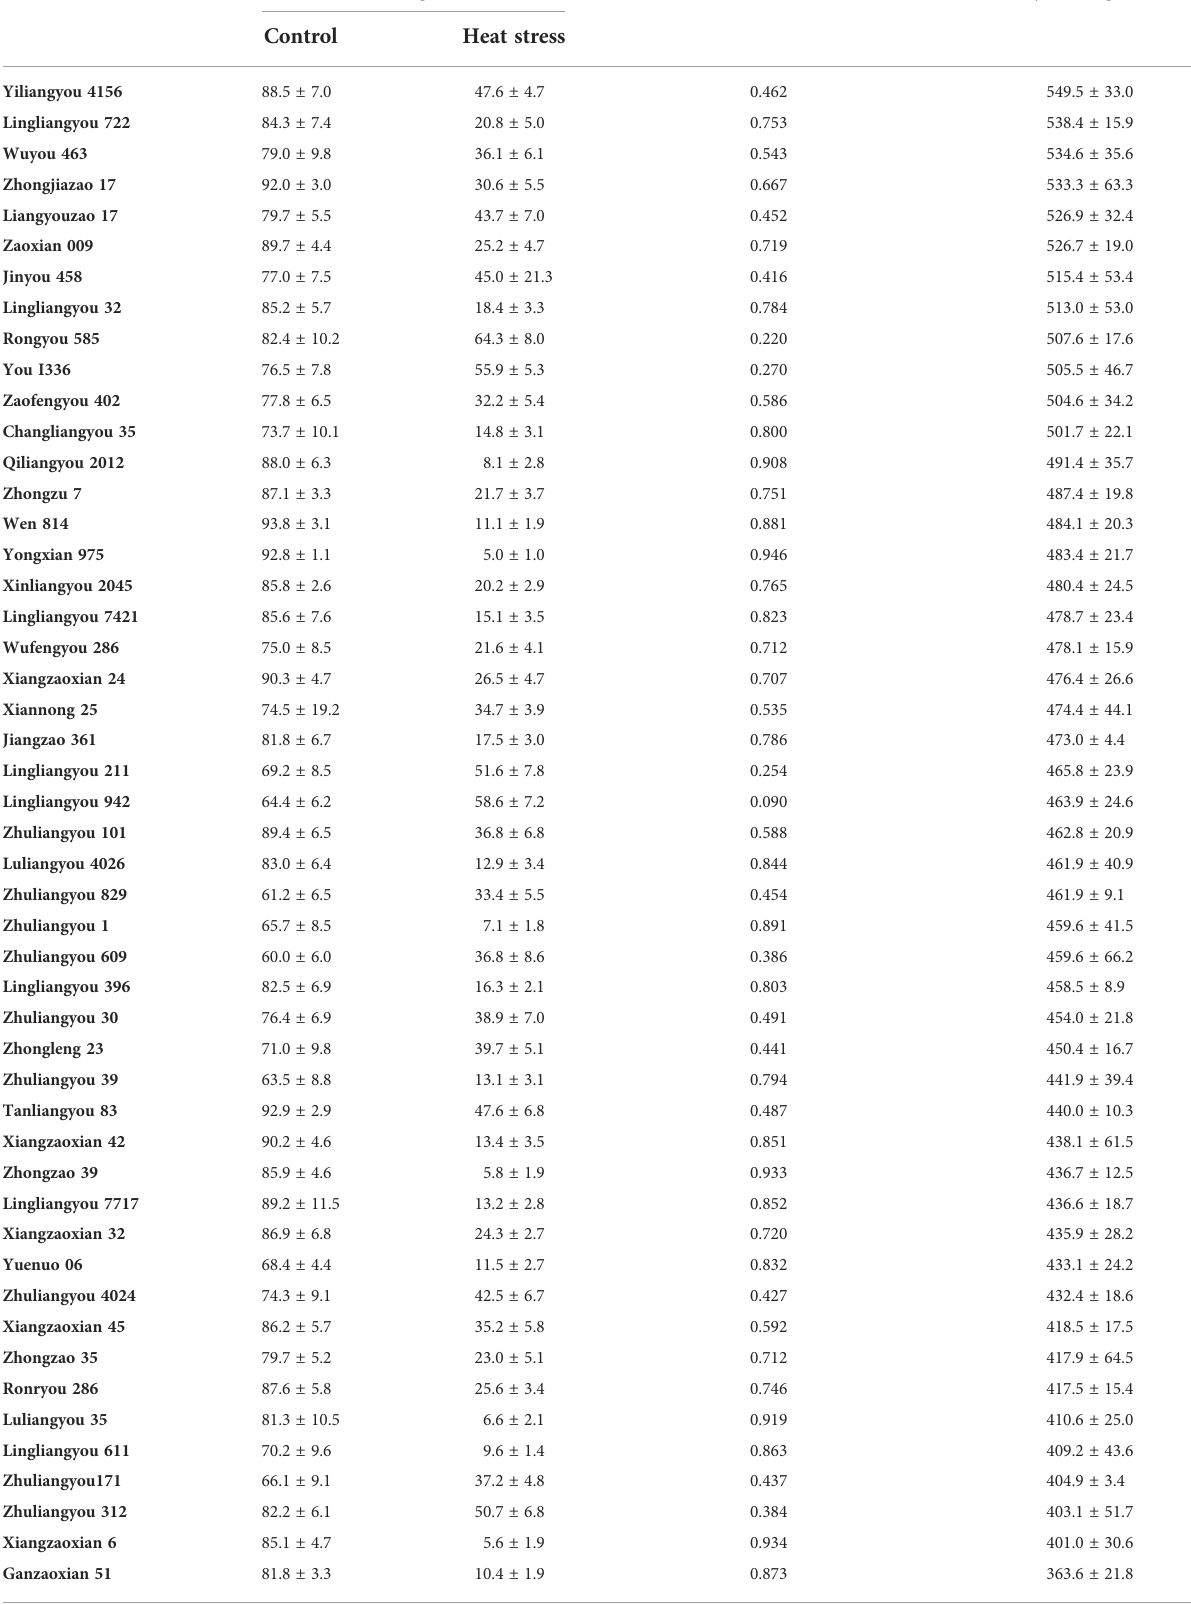
TABLE 1 Heat resistance and yield varied among forty-nine early rice